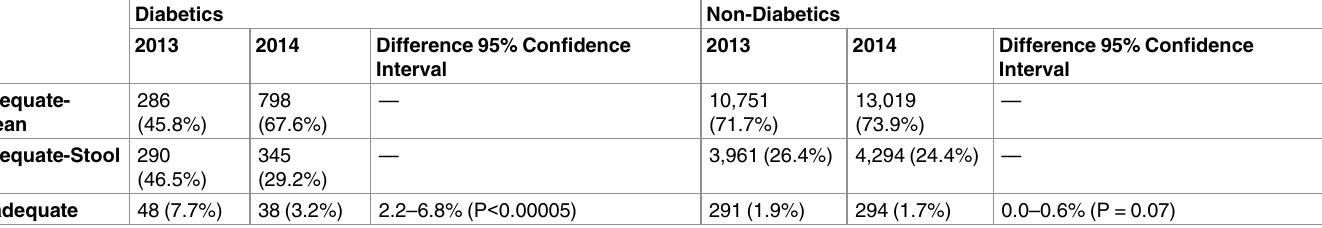
Table 2. Bowel preparation